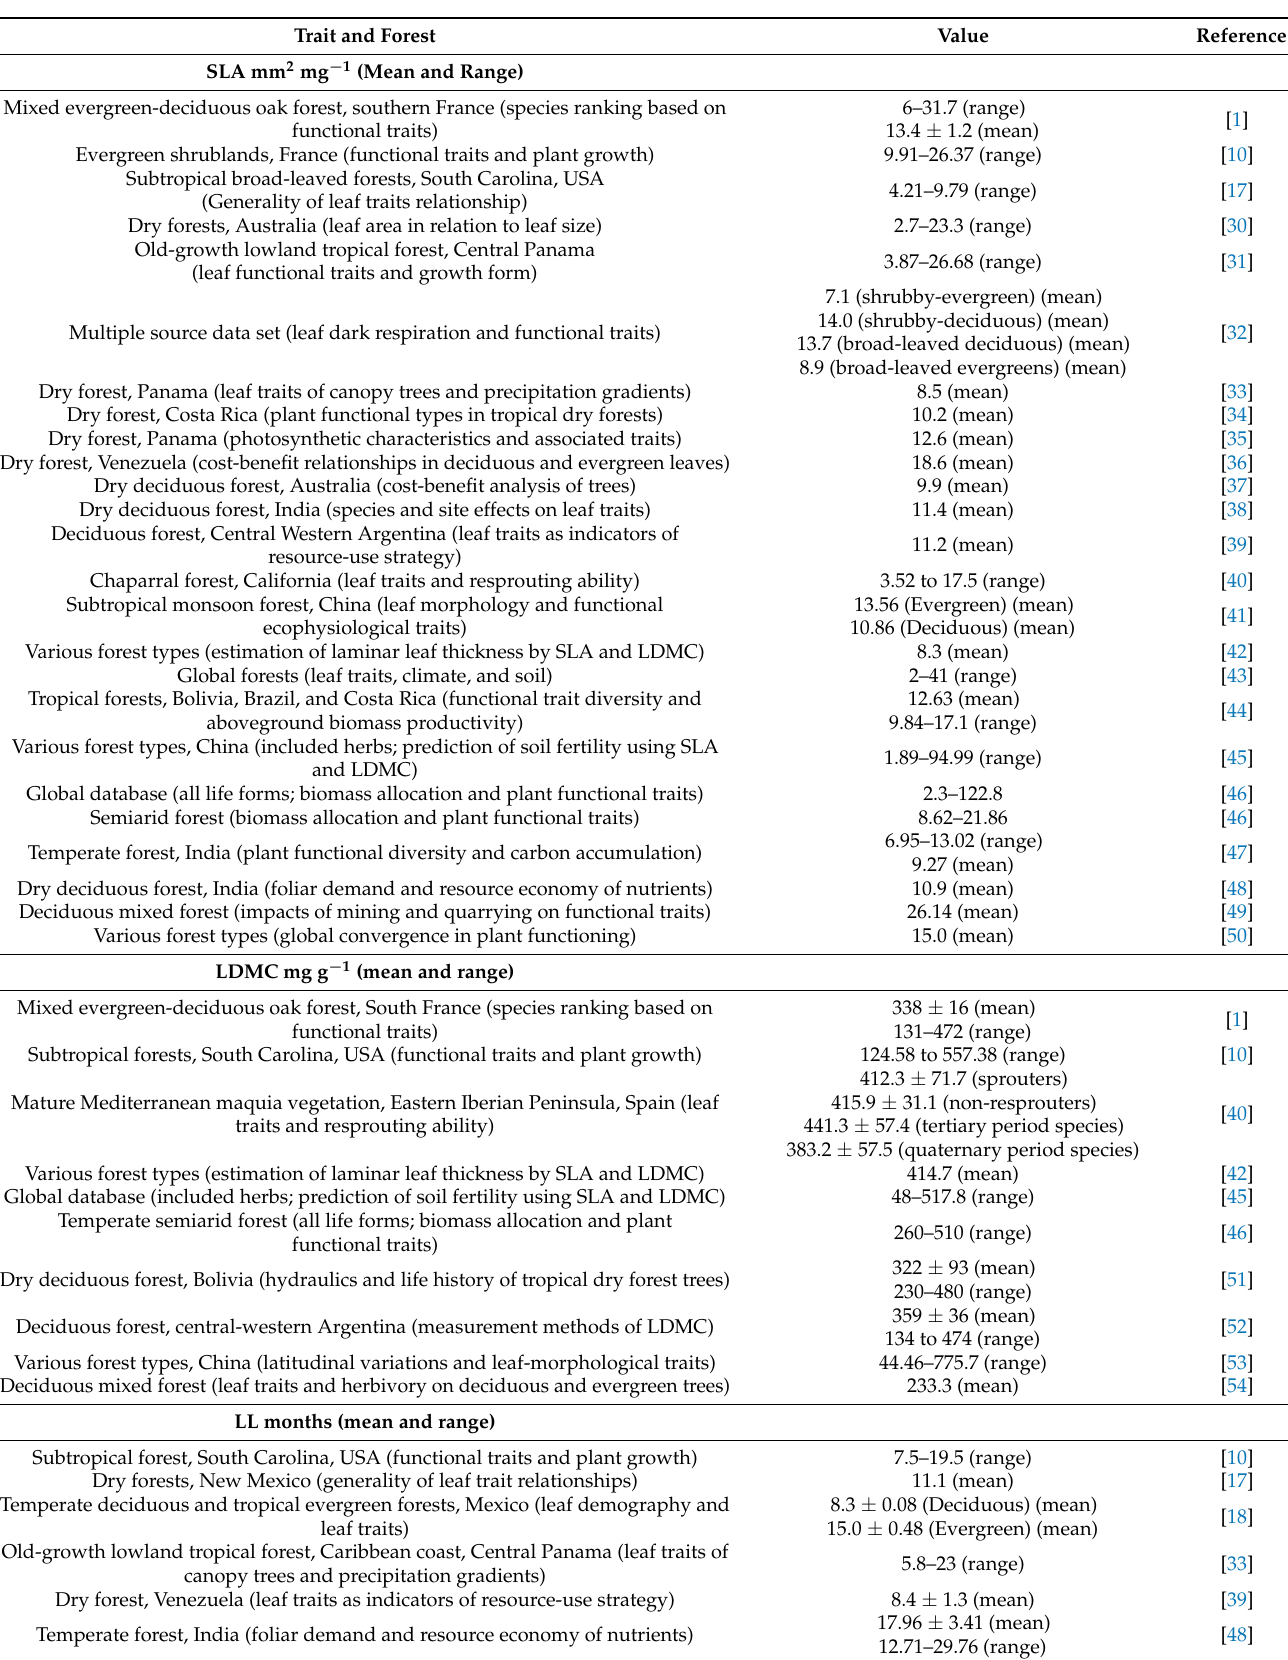
Table 2. Leaf trait values recorded from forest types around the world (ecological context of studies provided in parenthesis). Trait and